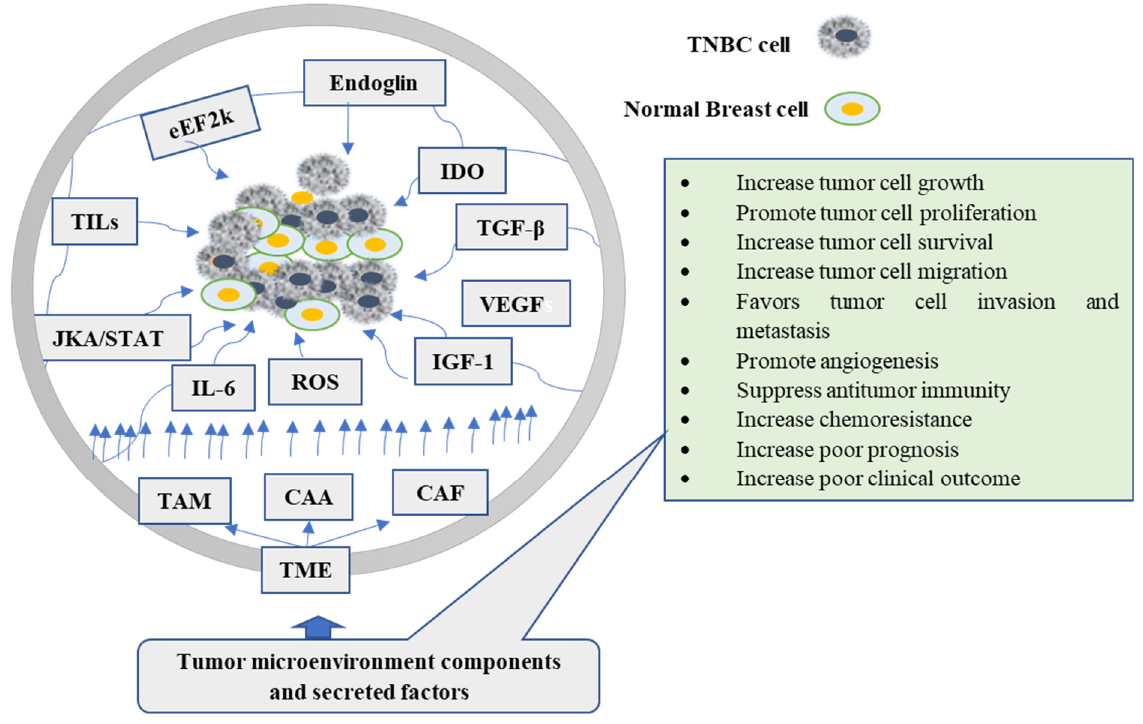
Figure 1. The role of tumor microenvironment components and their secreted factors in the carcinogenesis of TNBC cells. TAM, CAA, and CAF are the major cellular components of TME, while also shown in the figure are secreted factors and signals. CAA: Cancer-associated adipocytes; CAF: Cancer-associated fibroblast; eEF2k: eukaryotic elongation facto 2k; TAMs: tumor-associated macrophages; TGF- β : transforming growth factor- β ; IGF: insulin-like growth factor; ROS: reactive oxygen species; IL-6: Interleukin-6; TNBC: triple-negative breast cancer; VEGF: Vascular endothelial growth factor; IDO: Indoleamine 2,3-dioxygenase.